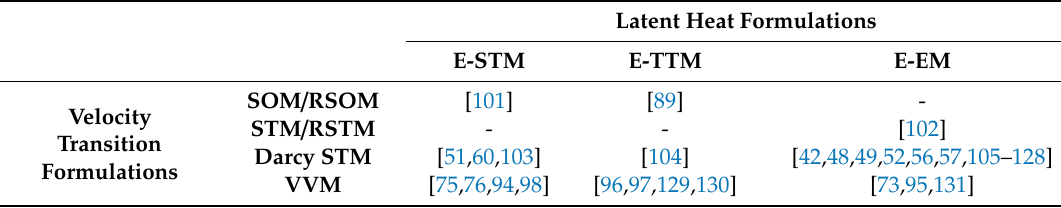
Table 3. Numerical formulations used in studies of